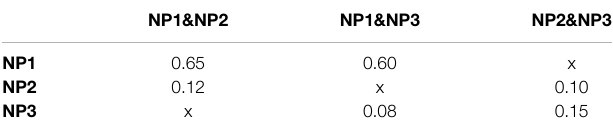
TABLE 12| Proportionofpronominalization ofambiguous referentsinthefullstop prompt items in Experiment 3, per referent, per ambiguous